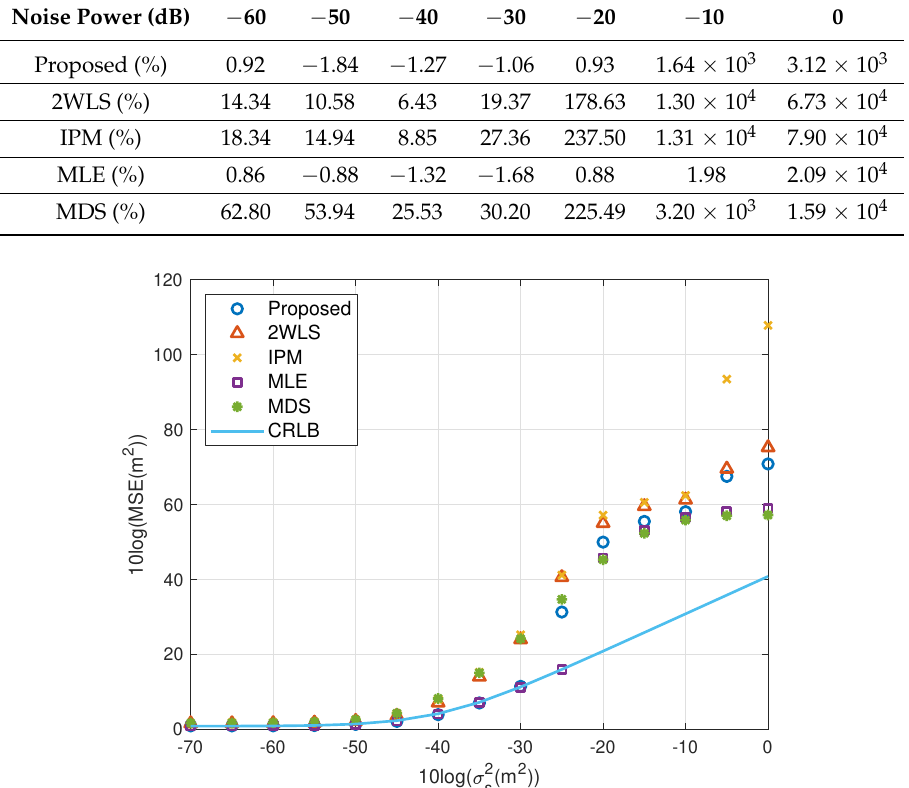
Figure 8. MSE performance as error level increasing (far source, 4 sensors).